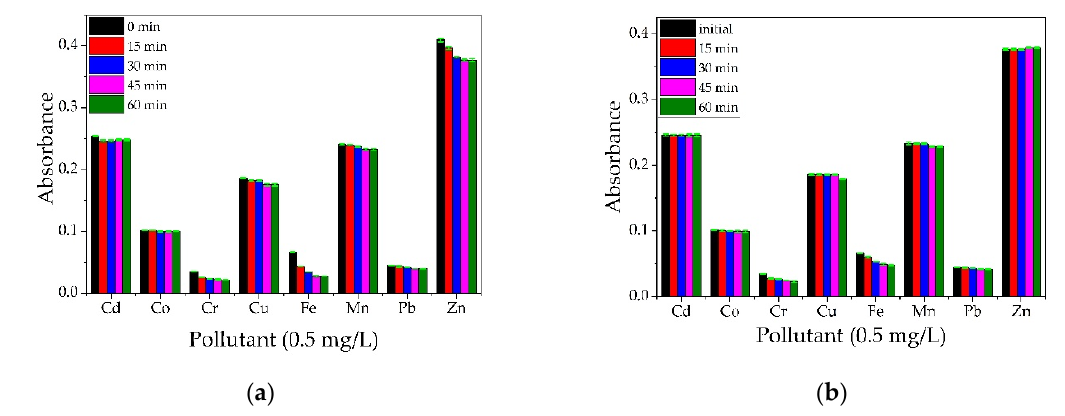
Figure 18. Qualitative analysis on a multielement solution (concentration 0.5 mg/L) for CS ( a ) and CS–BPA (1:1) mi- crobeads ( b ).